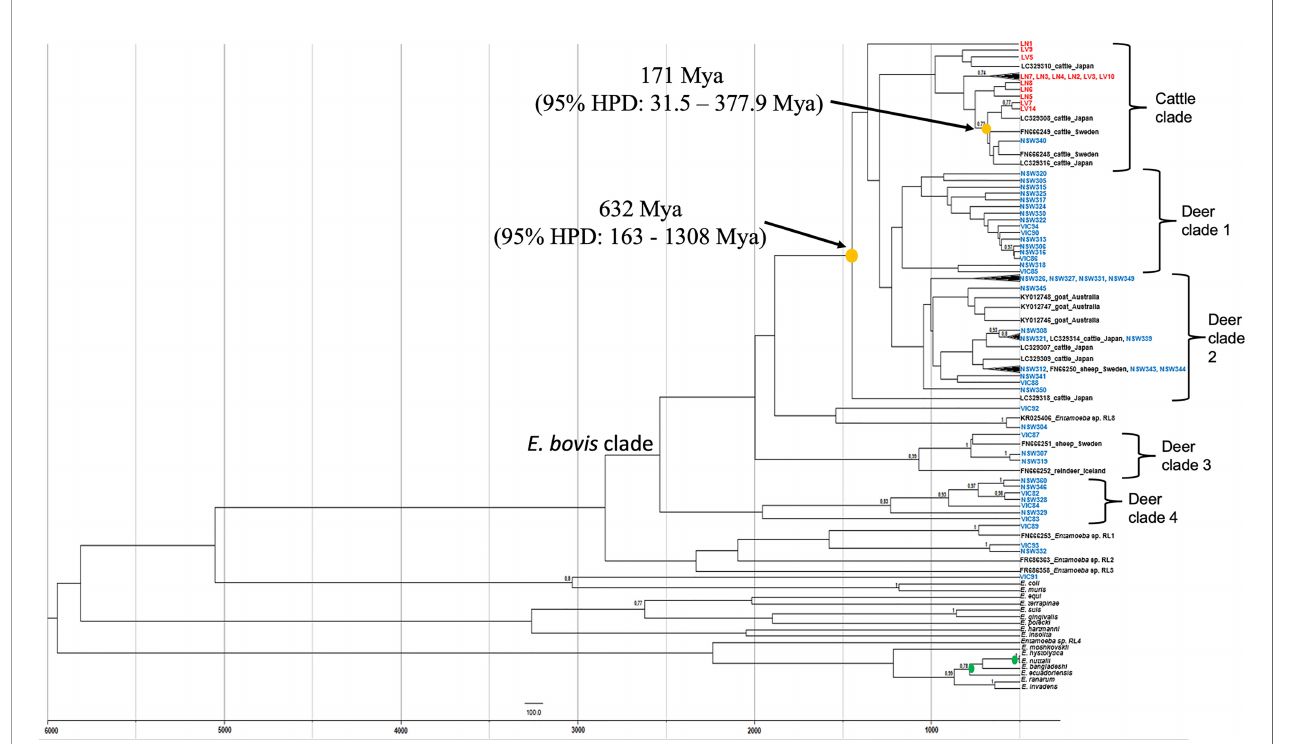
FIGURE 3 | Maximum clade credibility tree of Entamoeba obtained from Bayesian inference using split ages reported previously as calibrations (green dots). Yellow dots indicate the estimated mean ages for the most recent common ancestor (TMRCA) of Entamoeba detected in Australian wild deer and cattle. Deer sequences are indicated in blue and cattle sequences in red. Reference sequences are indicated in black. HPD, highest posterior density, Mya, Million years